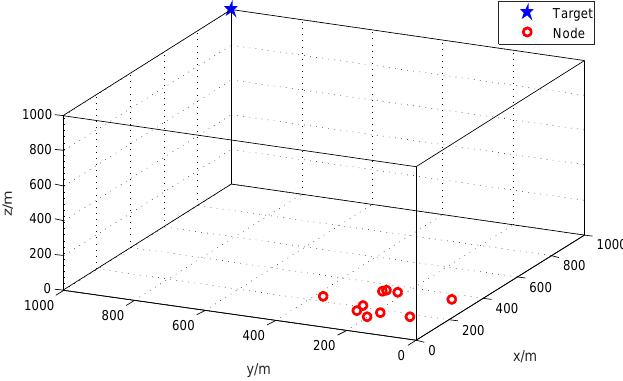
Figure 2. The geometry of the target and